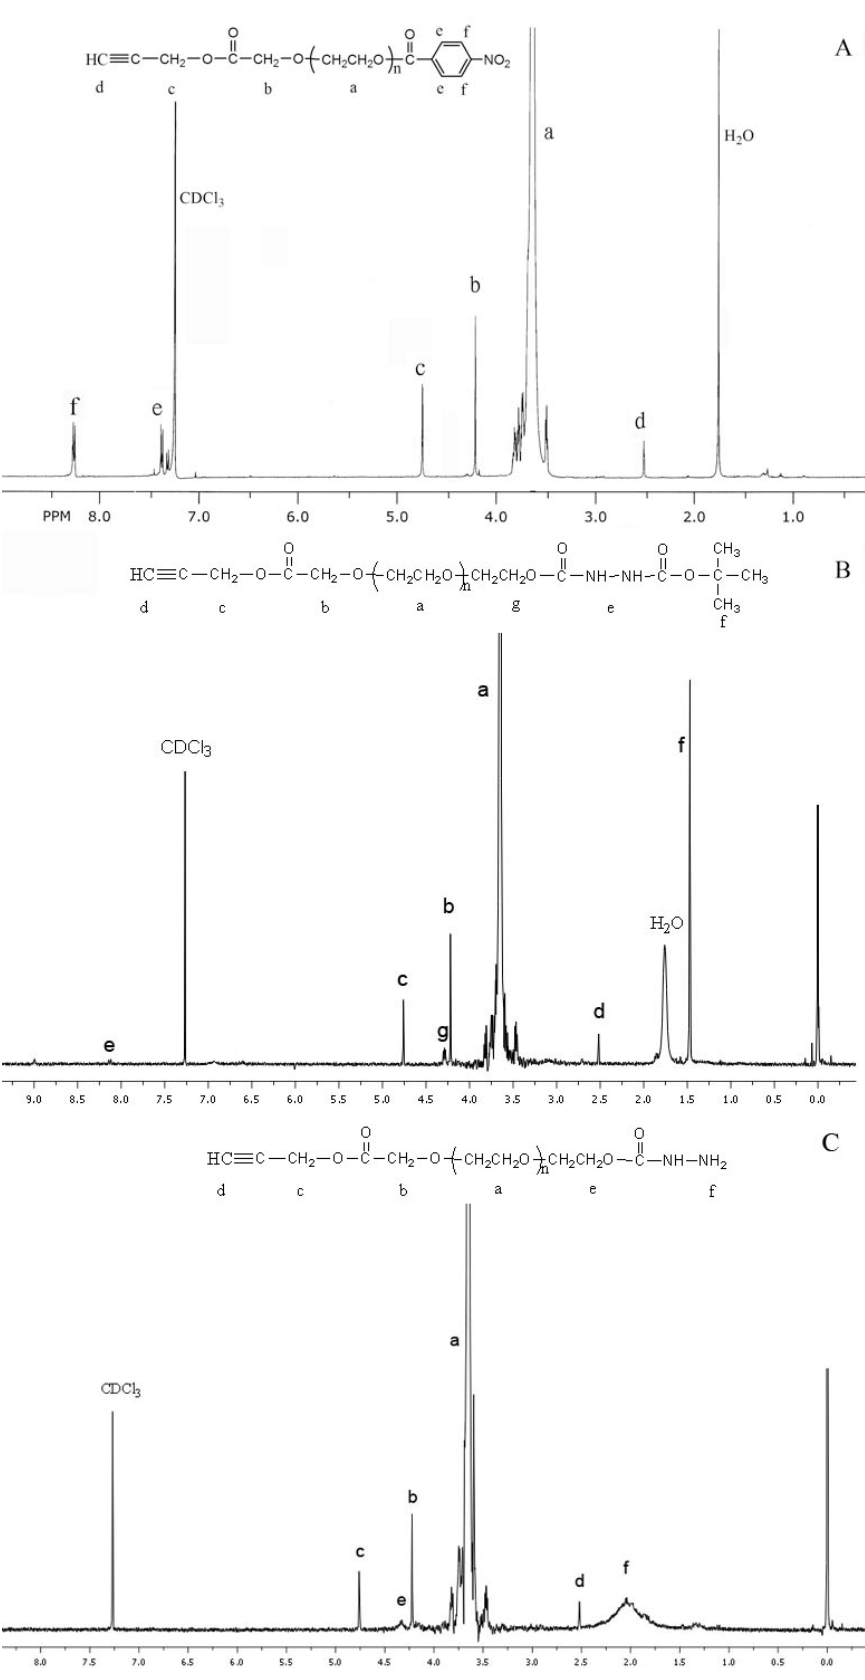
Figure 5. 1 H NMR spectra of (A) α - p -NPC- ω -propargyl PEG; (B) α - tert butyl carbazate- ω -propargyl PEG; (C) α -hydrazide- ω -propargyl